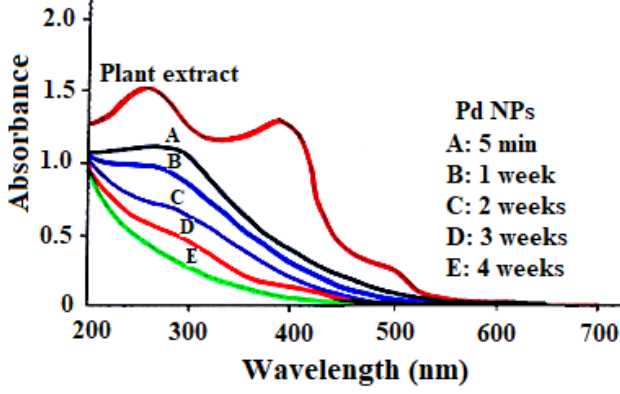
Figure 1. UV-Vis spectrum of plant extract and Pd NPs at different times.